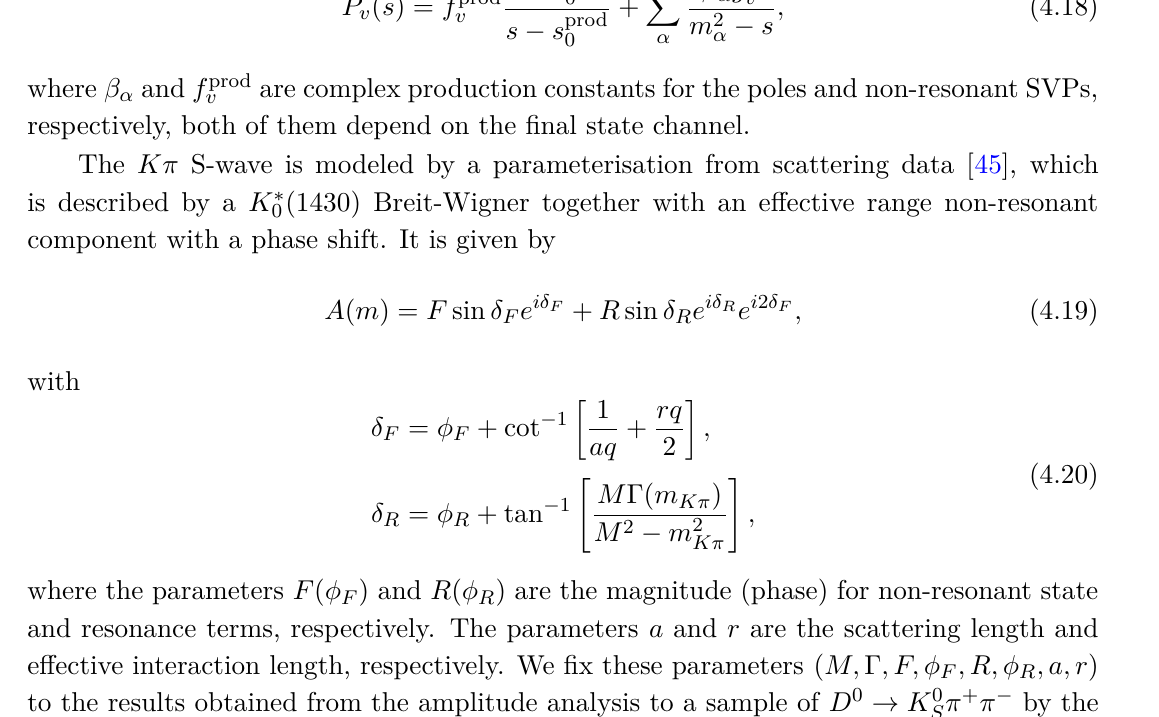
to the meson channel u . α